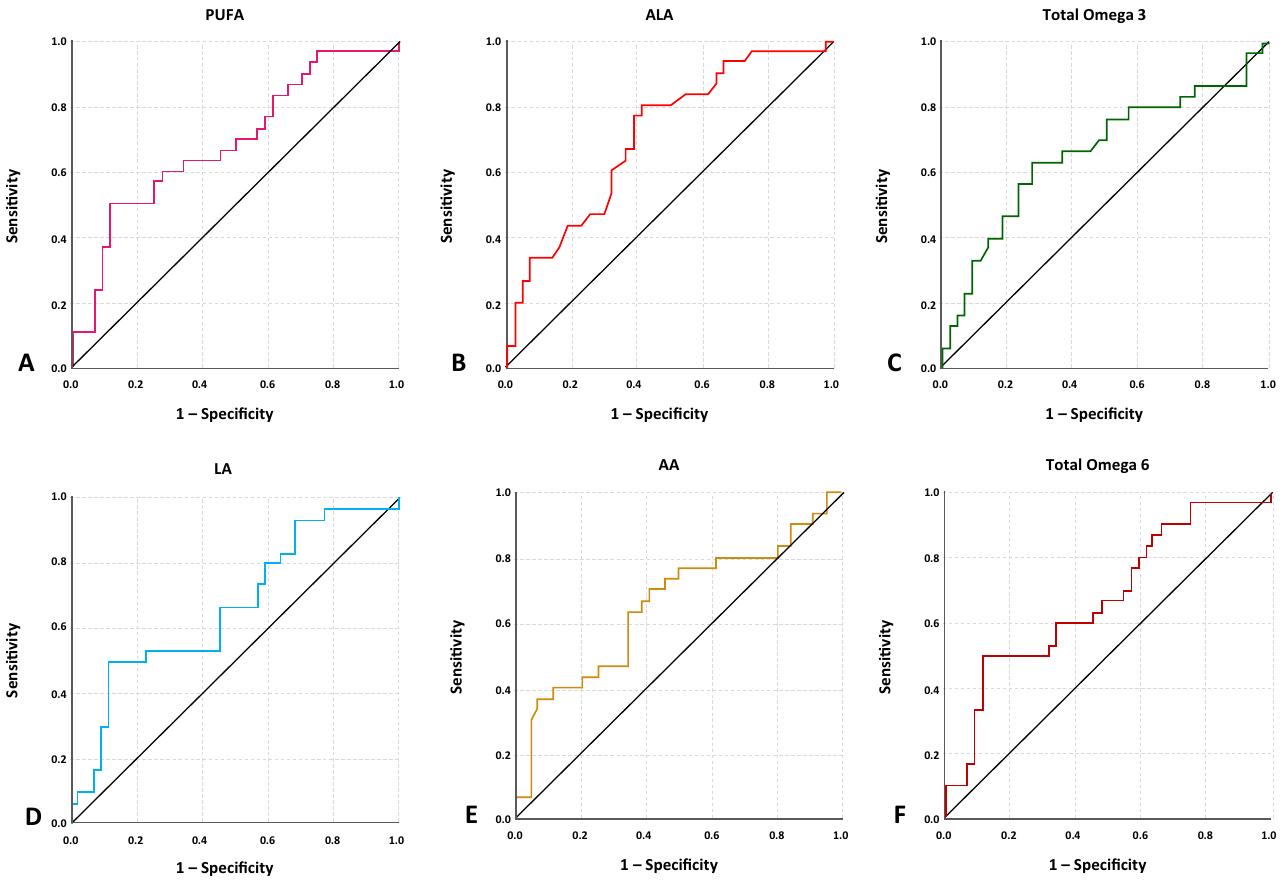
Figure 2. ROC curves of six LCPUFA parameters which are considered to be acceptable predictors in showing the risk of preterm birth by having AUC value >